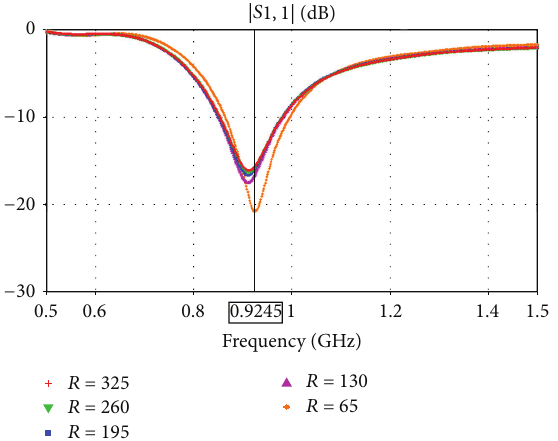
Figure 11: Resonance frequency of single-layer strip dipole antenna with difference curving radius (millimeters).